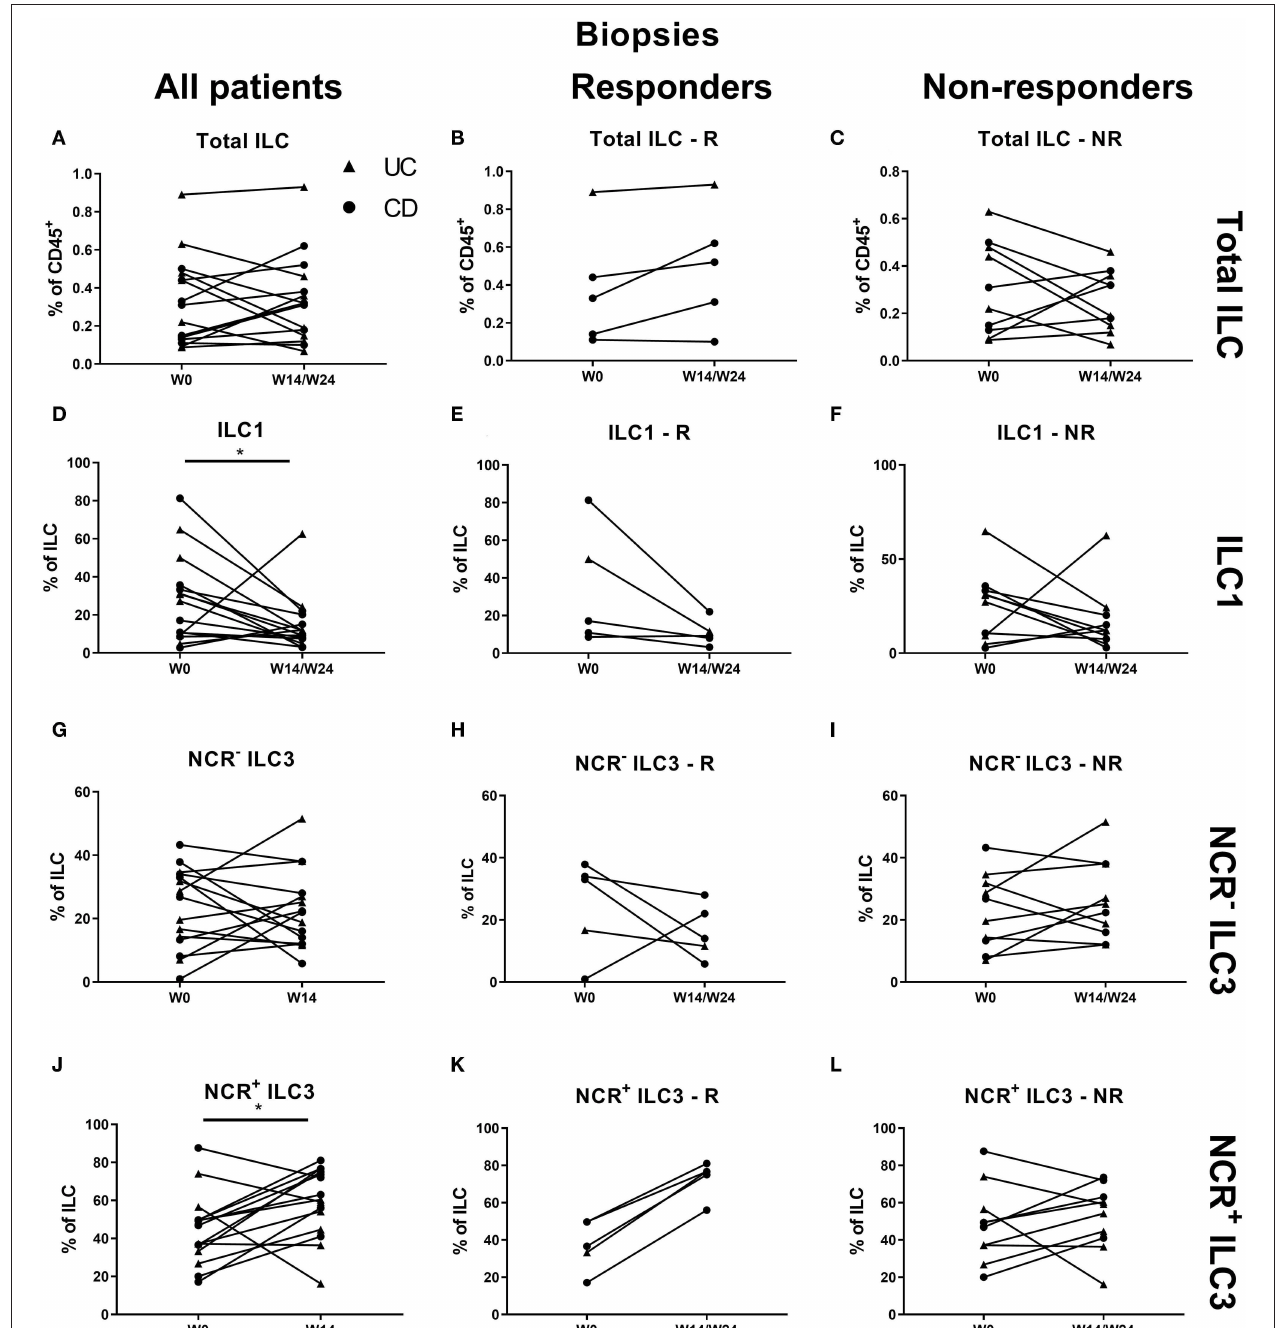
FIGURE 5 | Changes in intestinal ILC and ILC subpopulations upon anti-TNF treatment. Fifteen patients initiating anti-TNF treatment after endoscopic evaluation were subdivided into responders (R, n = 5) and nonresponders (NR, n = 10) based on endoscopic reevaluation at week 14 (UC, 1 ) or week 24 (CD, • ). Paired analysis of total ILC as proportion of CD45 + leukocytes in all patients (A) , in R (B) and in NR (C) . Paired analysis of ILCI as proportion of total ILC in all patients (D) , in R (E) and in NR (F) . Paired analysis of NCR − ILC3 as proportion of total ILC in all patients (G) , in R (H) and in NR (I) . Paired analysis of NCR + ILC3 as proportion of total ILC in all patients (J) , in R (K) and in NR (L) . Wilcoxon paired-match testing (D–L) ; * p < 0.05. NCR, natural cytotoxic receptor; ILC, innate lymphoid cell.